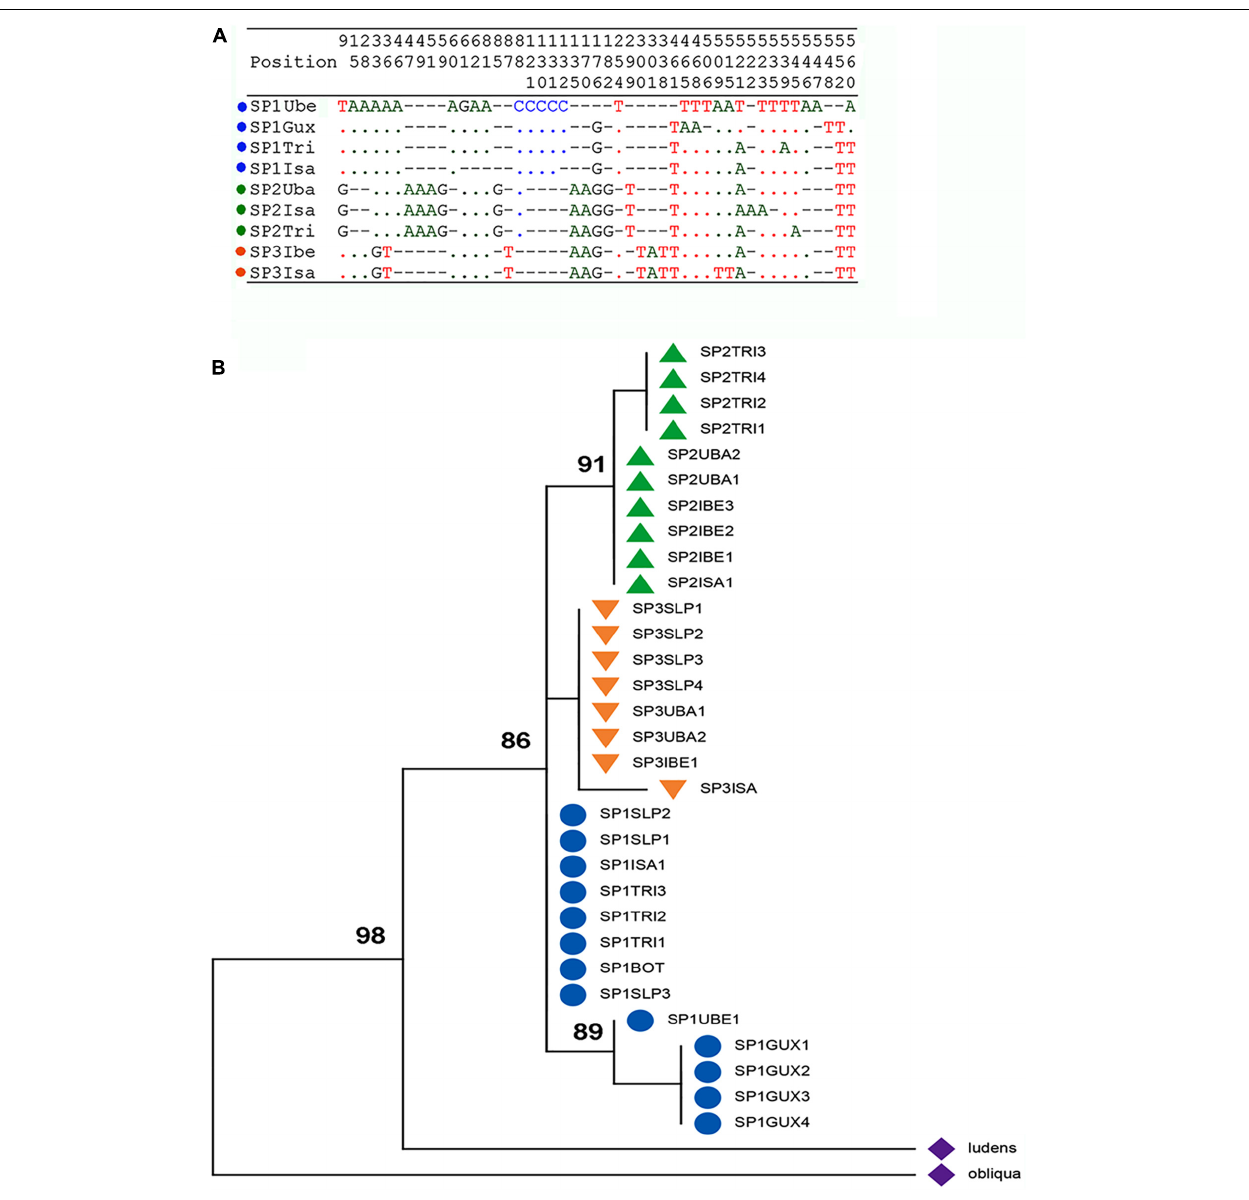
FIGURE 3 | Analysis of ITS-1 sequence of the Anastrepha fraterculus complex from Brazil. (A) Polymorphic sites of the nine representative ITS-1 sequences; similarities are shown by dots and differences among the sequences by letters and gaps (–). (B) Phylogenetic relationships of the ITS1 sequences of the AF complex from Brazil. The evolutionary history was inferred using the maximum likelihood method based on the general time reversible model. The numbers at the nodes are bootstrap values (1,000 replications). Sequences of A. ludens and A. obliqua were used as